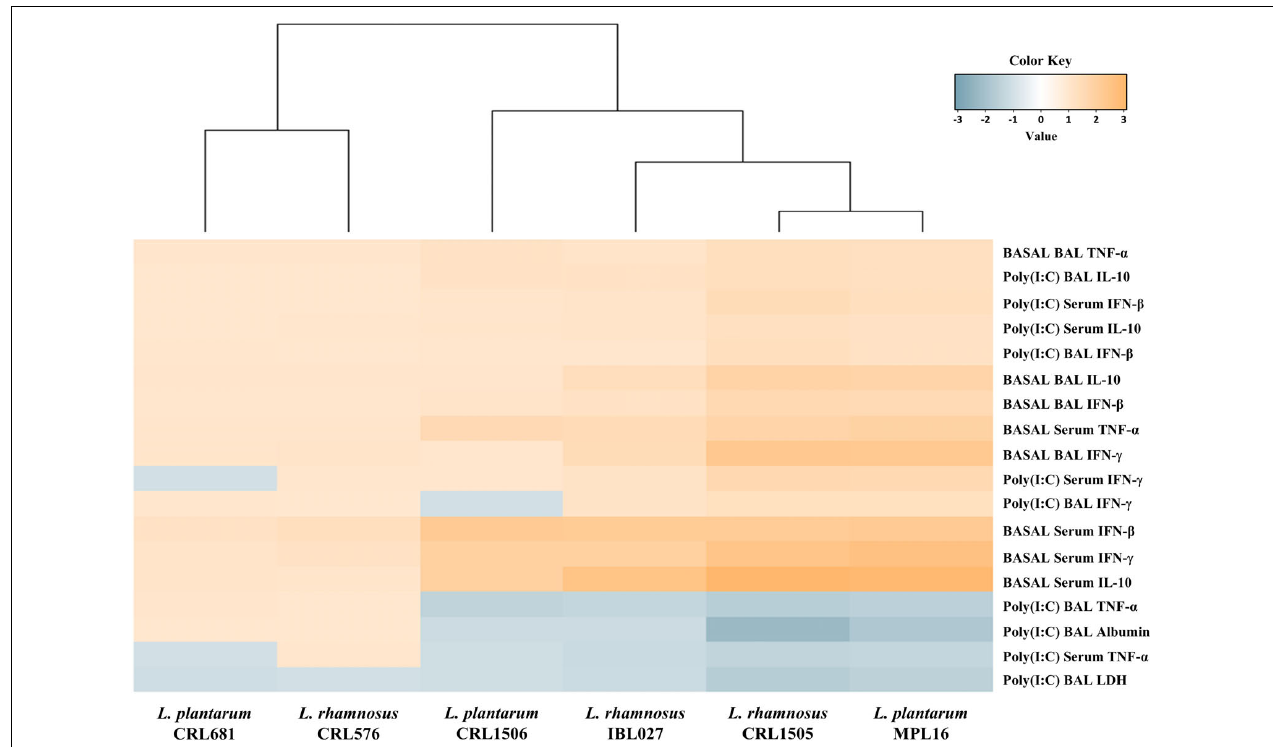
FIGURE 9 | Heat map analysis of the differentially regulated serum and bronchoalveolar lavage (BAL) immune factors and BAL injury markers before (basal) and after poly(I:C) challenge. Mice were orally treated with Lactobacillus rhamnosus CRL1505, L. rhamnosus IBL027, L. rhamnosus CRL576, Lactobacillus plantarum CRL1506, L. plantarum MPL16, or L. plantarum CRL681 and then challenged by the nasal route with the viral molecular–associated pattern poly(I:C) for three consecutive